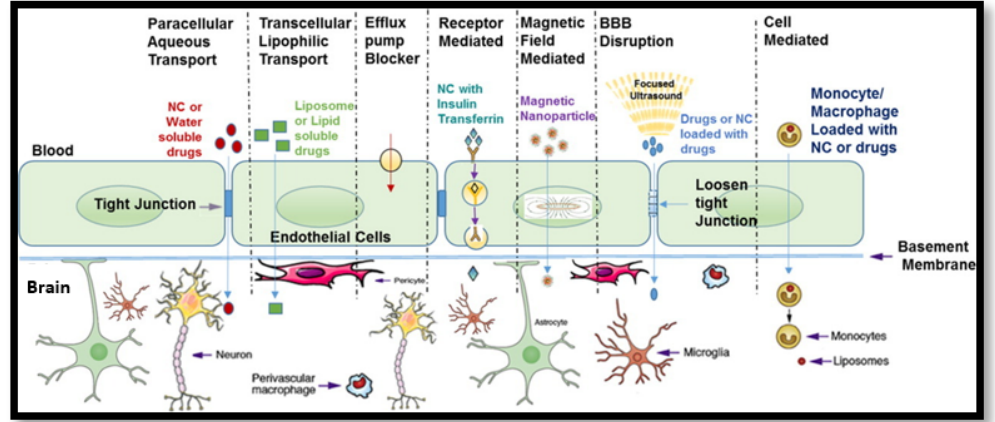
Figure 3. Summary of non-invasive transport mechanisms available for the delivery of nanoparticulate systems across the BBB. Reproduced from Nair and colleagues.